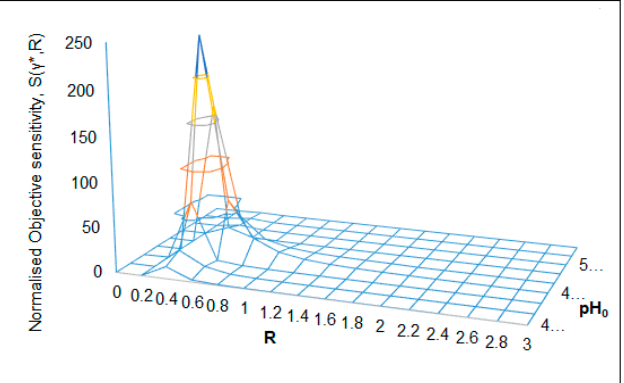
Figure 9. Normalized objective sensitivity S( γ *, R) as a function of parameters R and pH 0 .